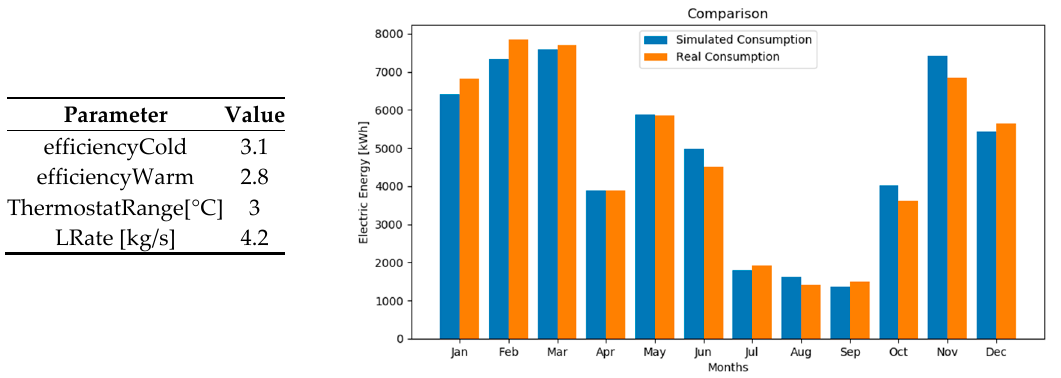
Figure 4. Calibration uncertain parameters on the right and Comparison of Real vs Simulated energy consumption of the Computer Lab 2016